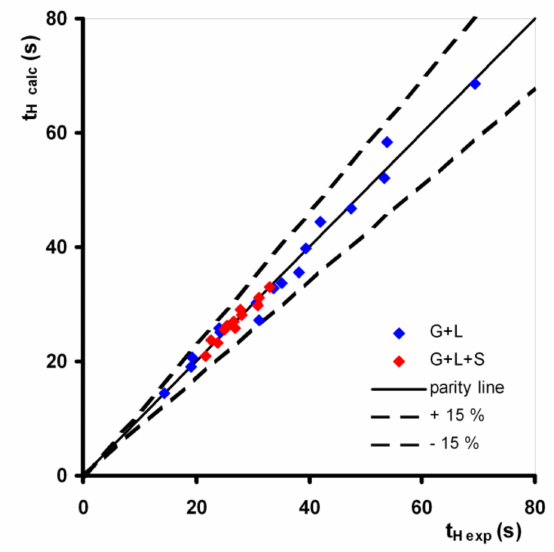
Figure 7. Homogenization time t H : Comparison of experimental and calculated data using (7)—parity